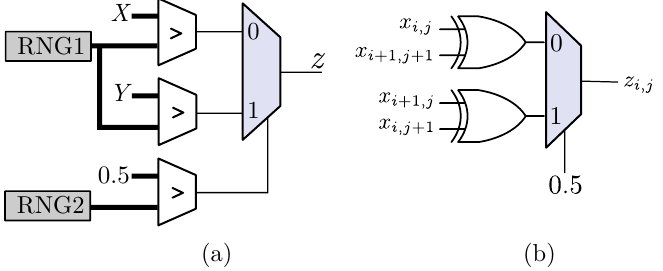
Figure 11. ( a ) Scaled addition test setting. ( b ) SC Roberts edge detection circuit exploiting correlation. Table 4. MAE for the scaled addition circuit using different RNGs. The best result for each column is highlighted in bold.